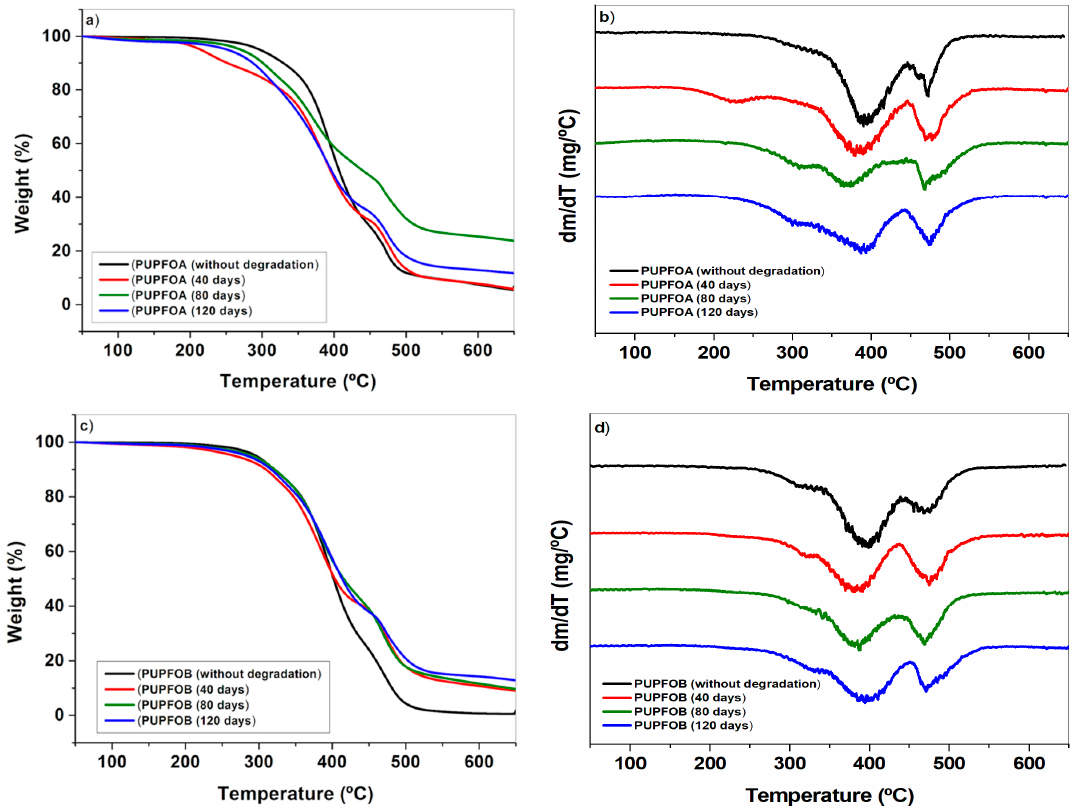
Figure 10. Thermal analysis curves: PUPFOA ( a ) TG and ( b ) DTG; PUPFOB ( c ) TG and ( d ) DTG. Heating rate: 10 °C/min.